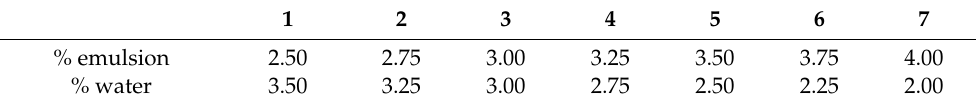
Table 8. Families of test samples conformed with RAP and BBA or limestone aggregate.